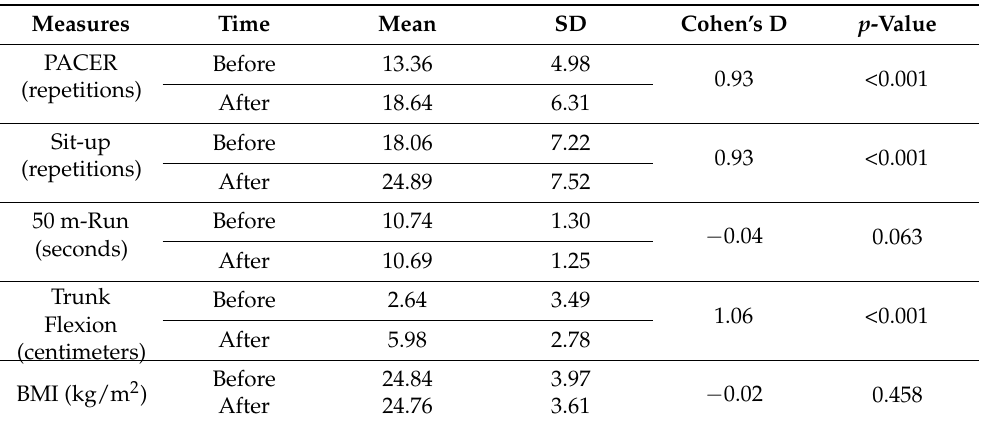
Table 3. Descriptive Statistics for Five PAPS Measures ( n =